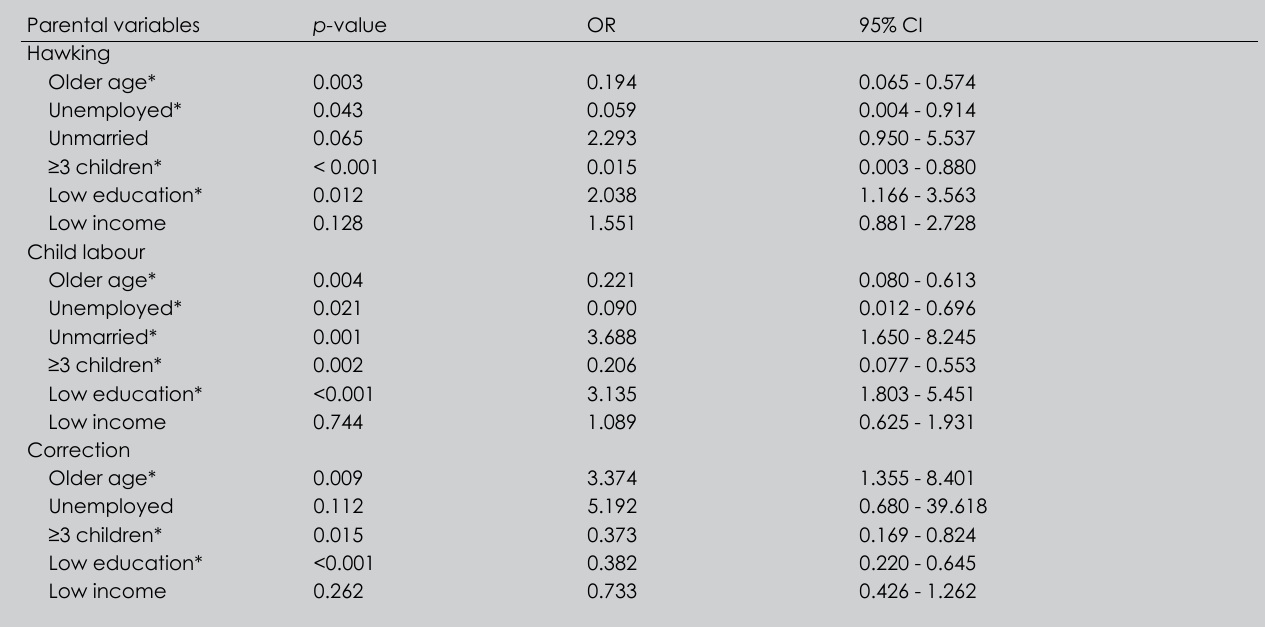
Table III. Multivariate logistic regression of socio-demographic variables and recognition of child abuse Parental variables